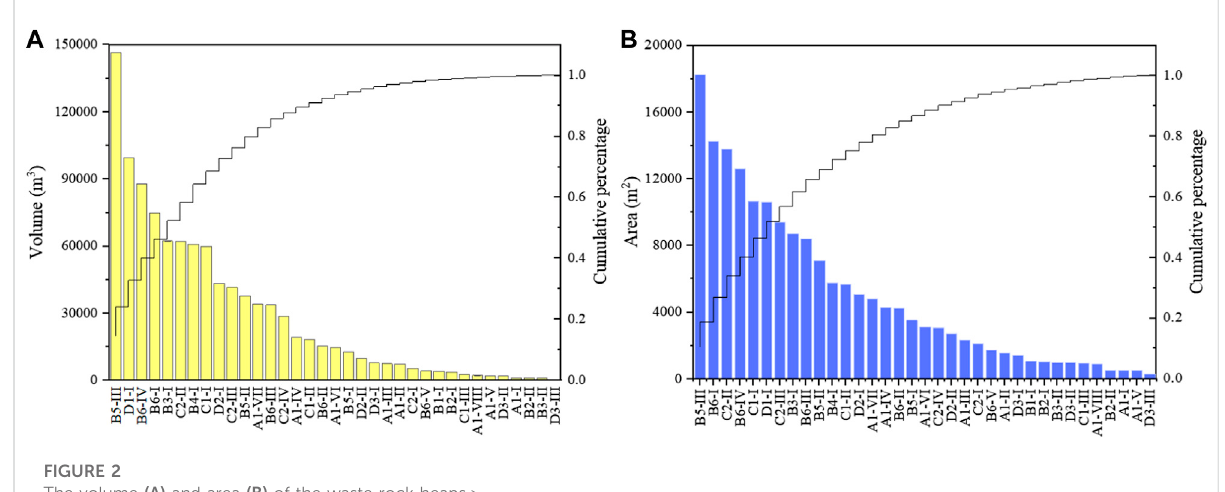
FIGURE 2 The volume (A) and area (B) of the waste rock heaps. >